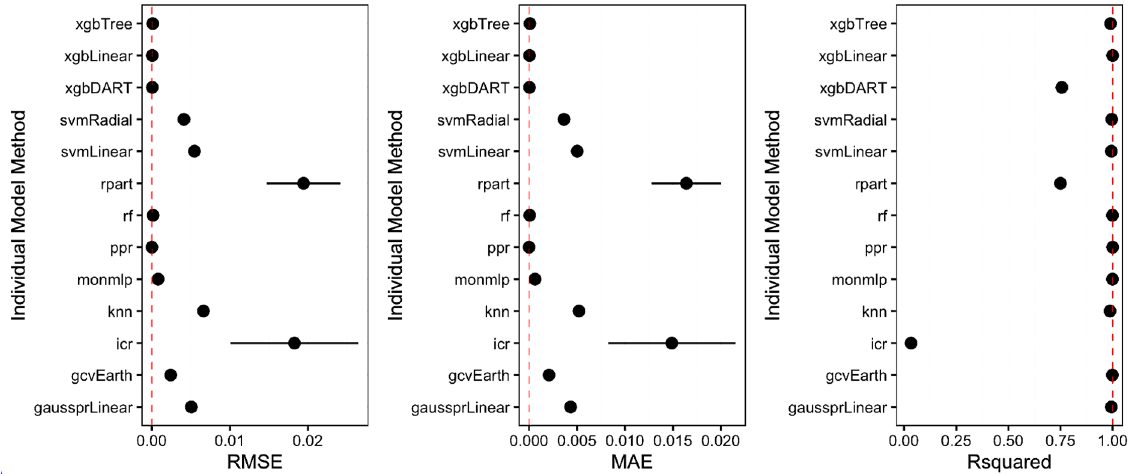
Figure 7. The cooperative model versus the classical ML algorithms: comparison of the cooperative model with the classical ML models over the training data set. The red-dashed line represents the cooperative model. We observe that the cooperative model’s performance is even slightly better the most accurate classical ML models.